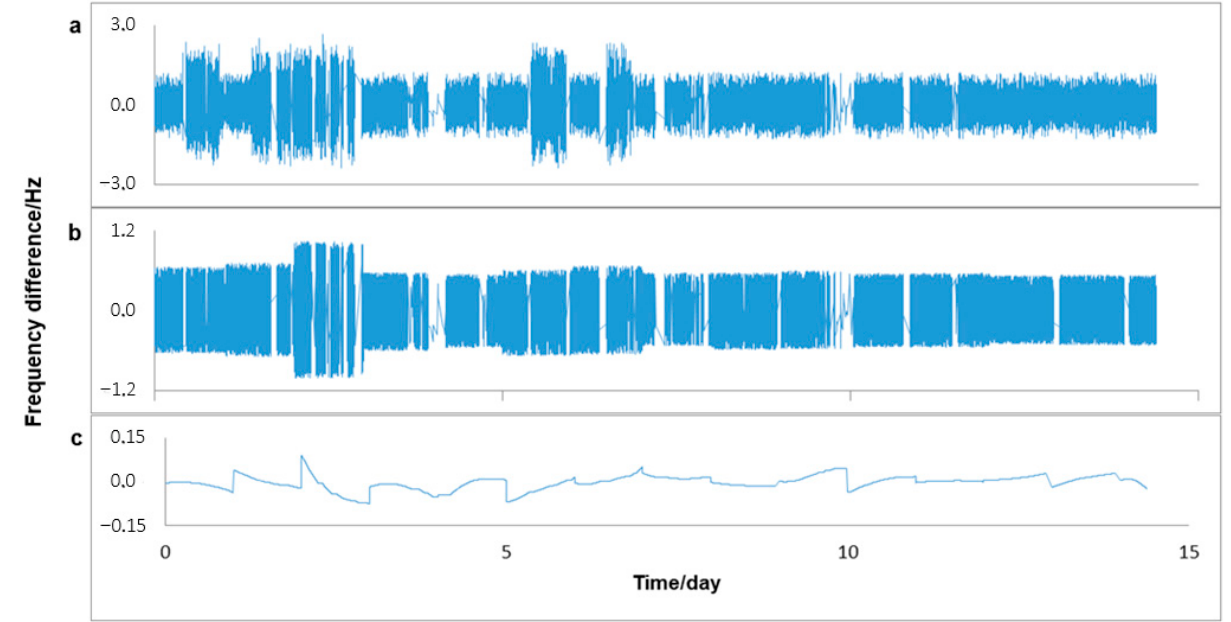
Figure 3. The frequency difference measurement between two optical clocks located at the same site. ( a ) Original data; ( b ) residual data after data processing, namely the gross errors removed; and ( c ) residual data after